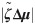
Steady state velocity versus |ζ˜Δμ| over a range of contractile activity values for different binding rates kb = koff = kon.Insets show steady state configurations with concentration on interface shown by colour density (black to yellow) and blue arrows show the velocity. Higher binding rates reduce the droplet speed and enables the formation of two concentration peaks (see insets (b) and (c)). Simulation parameters: Db = 0.5, D = 0.05, B = 0.5, γ0 = η = R0 = c0 = 1.